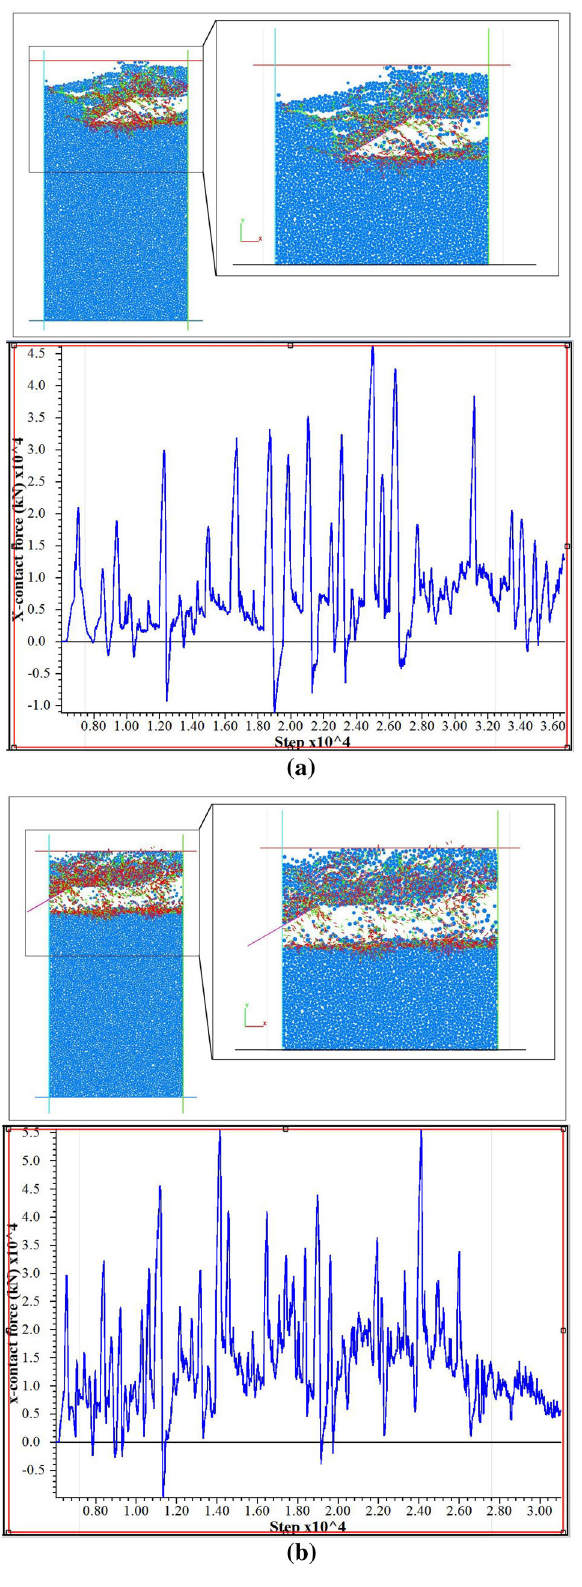
Fig. 12 Results of plow model with zero-degree angle: a Model 11, b Model